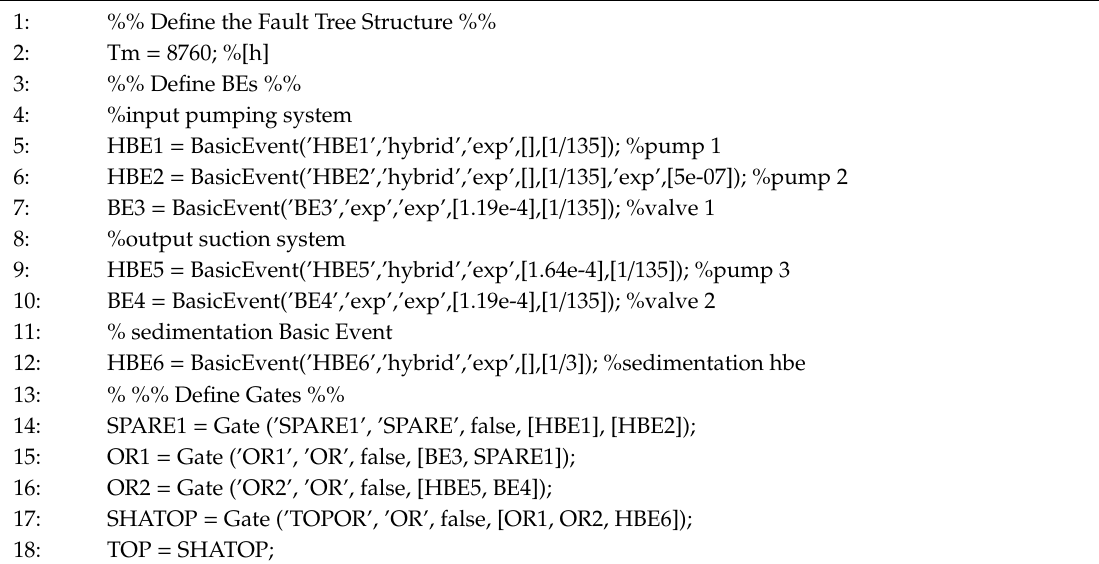
Algorithm 1. Code for the definition of a fault tree using the SHyFTOO